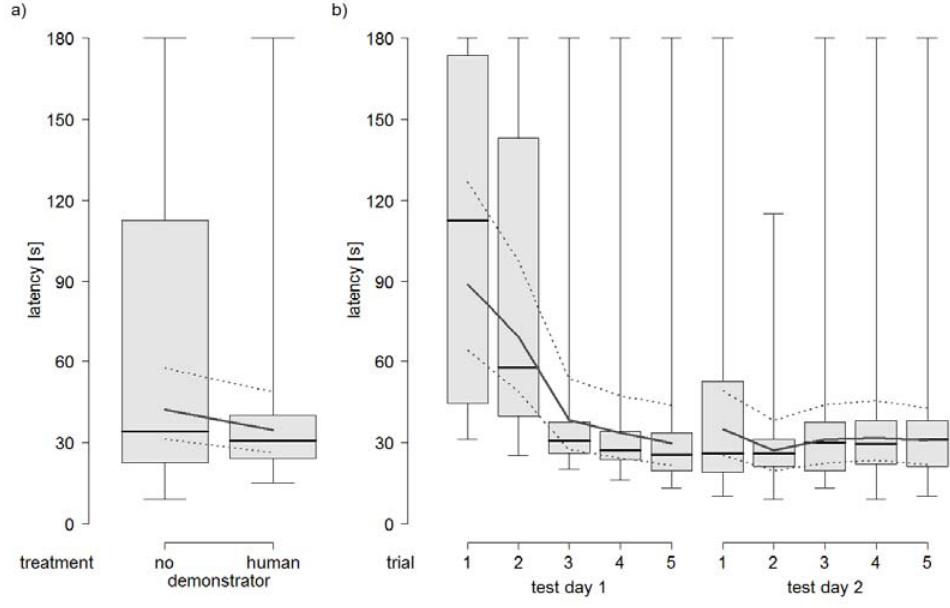
Figure 3. Latency to reach the rewarded bucket in ( a ) the two different treatments and ( b ) trial 1 to 5 on test day 1 and